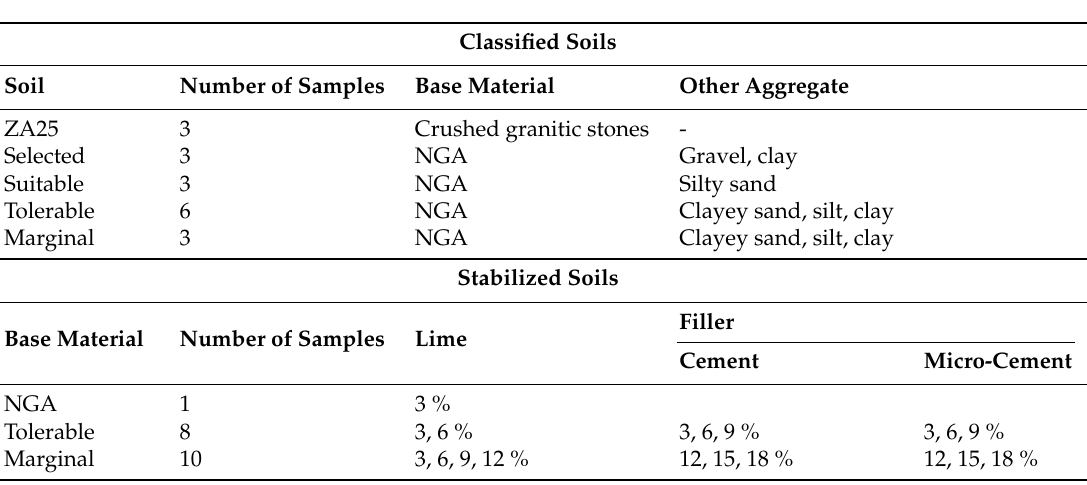
Table 3. Sampling performed in this study.